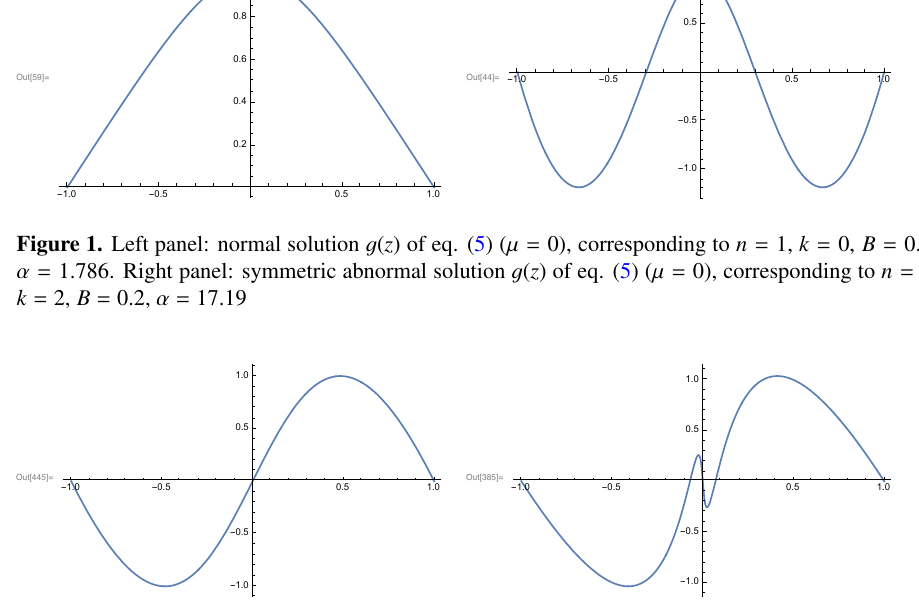
Figure 2. Antisymmetric abnormal solutions g ( z ) of eq. (5) ( µ = 0). Left panel: n = 1, k = 1, B = 0 . 2, α = 8 . 25. Right panel: n = 1, k = 3, B = 10 − 4 , α = 2 .